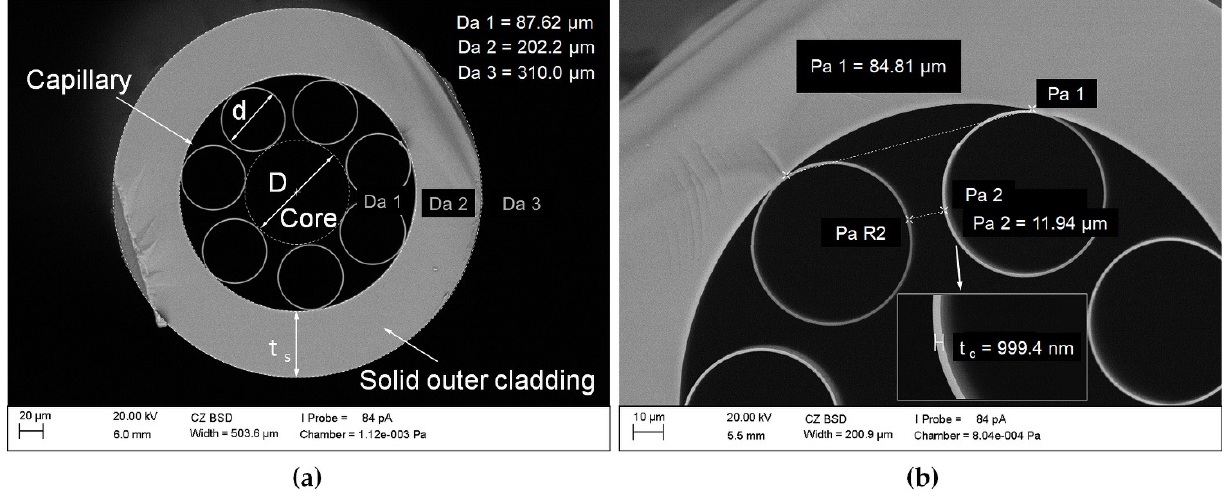
Figure 1. Scanning Electron Micrograph (SEM) cross-sectional image of the ARHCF: ( a ) view of the ARHCF with an air core of 87 µm and ( b ) view of the capillaries forming the fiber cladding.